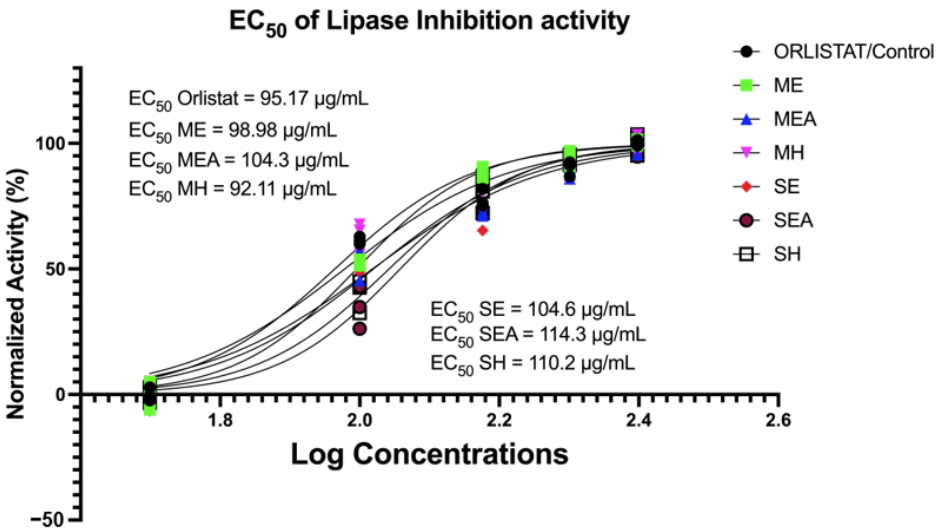
Figure 2. The half-maximal effective concentration (EC 50 ) of lipase inhibition activity. Figure 2. The half ‐ maximal effective concentration (EC 50 ) of lipase inhibition activity. ME : Maceration — Ethanol; MEA : Maceration — Ethyl Acetate; MH : Maceration — n ‐ Hexane; SE :